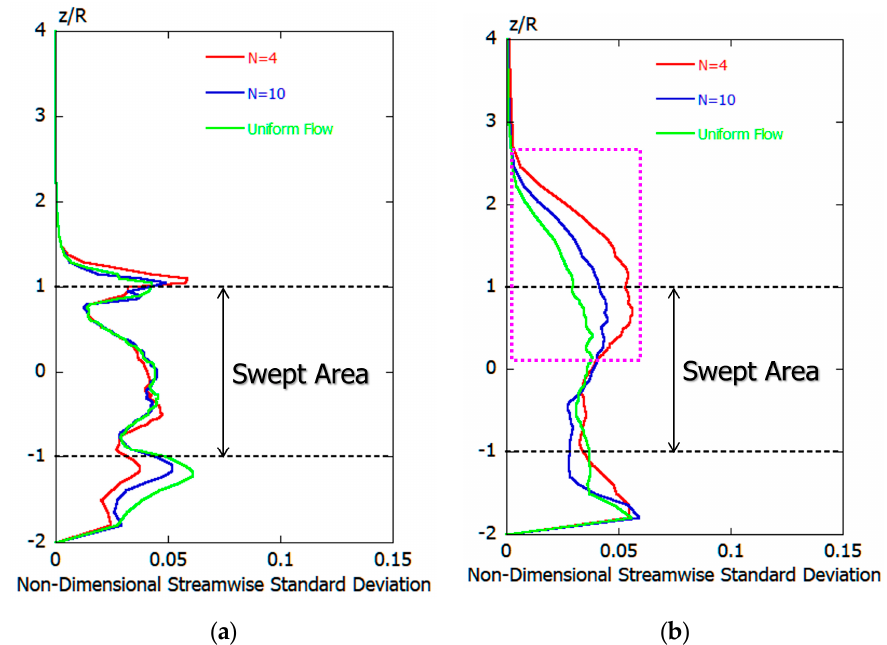
Figure 21. Comparison of vertical distribution of nondimensional streamwise standard deviation: ( a ) x = 5.0 D; ( b ) x = 30.0 D.